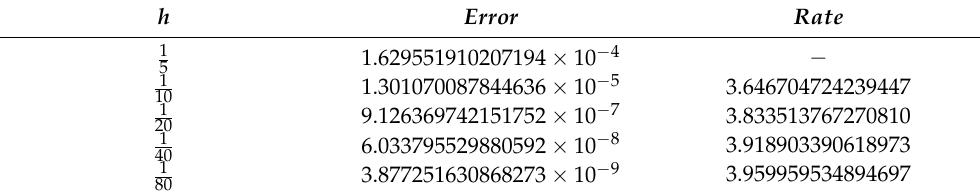
Table 1. Maximum errors and convergence rate as functions with h .